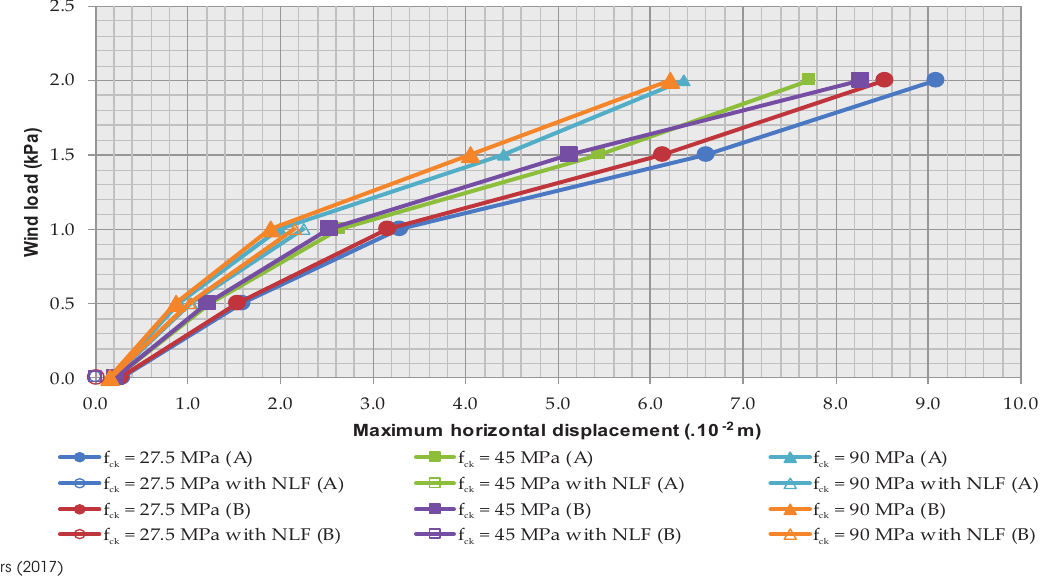
Maximum horizontal displacement on the AASHTO beam Type